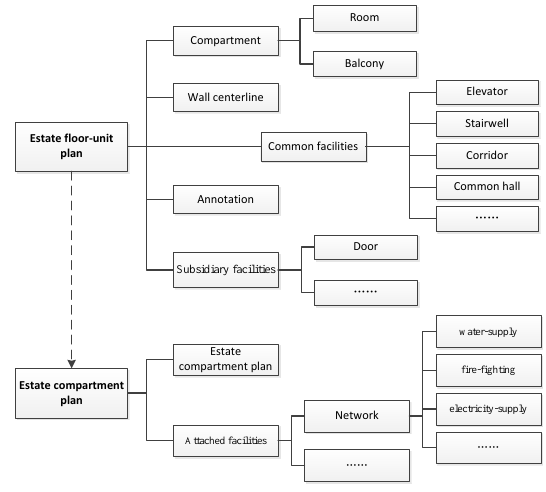
Figure 2 Estate floor-unit plan, compartment plan and their relationships